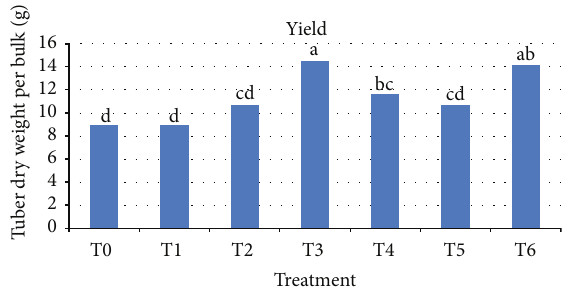
Figure 3: Final tuber dry weight (g) per bulk for each